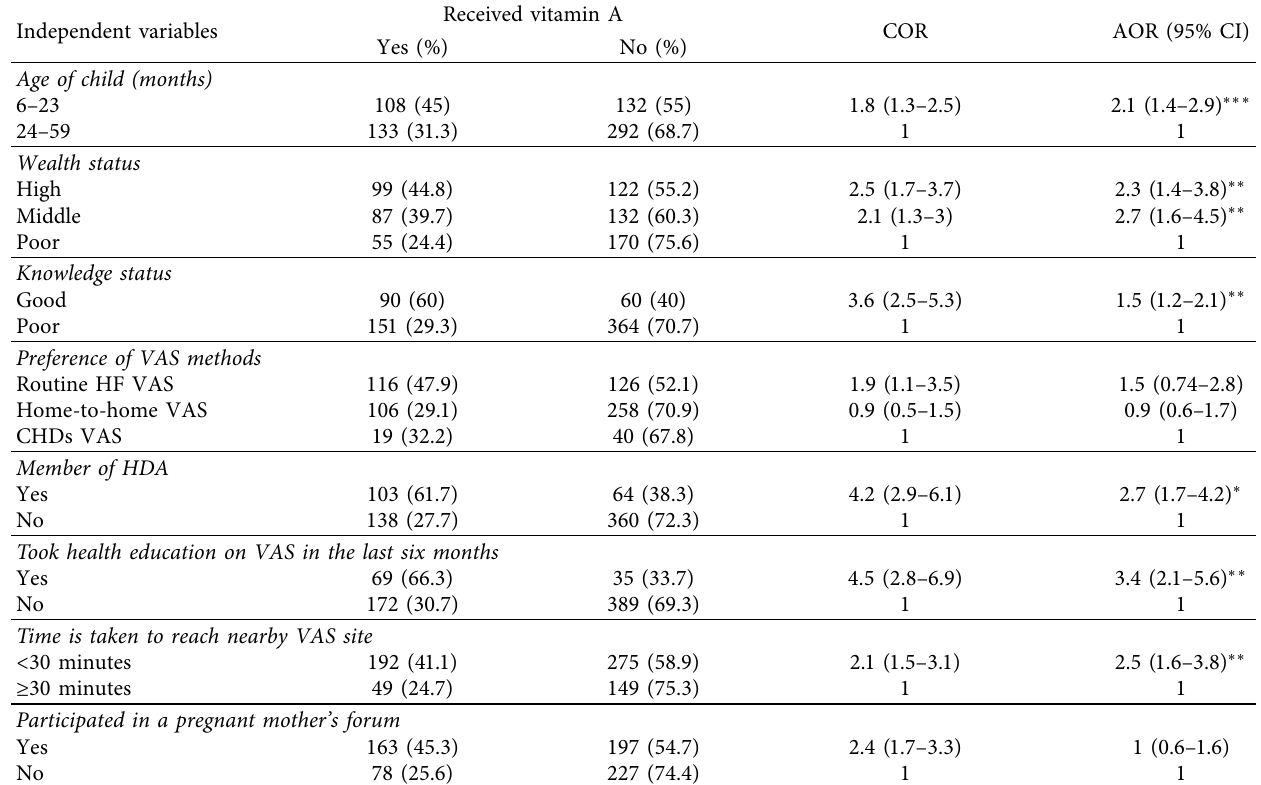
Figure 3: Prevalence of ocular signs of vitamin A deficiency among children aged 6–59 months in Aleta Chuko woreda, SNNPR, Table 7: Factors significantly associated with the utilization of VAS among children aged 6–59 months in Aleta Chuko woreda, SNNPR, 2019.